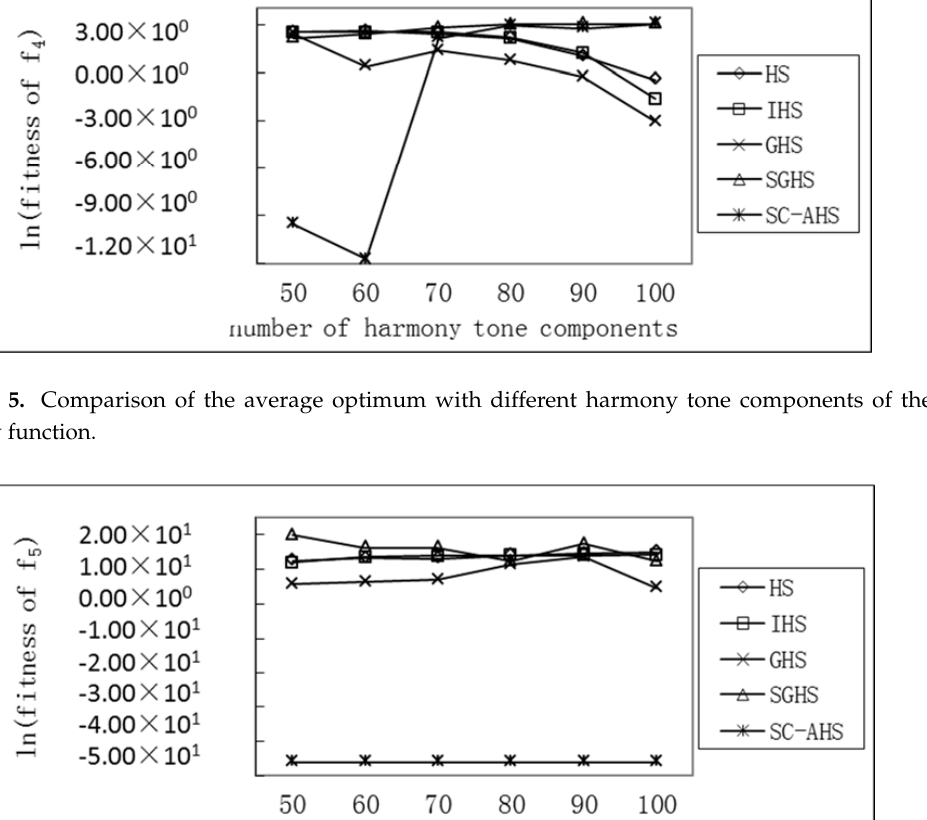
Figure 6. Comparison of the average optimum with different harmony tone components of the Rosenbrock function.